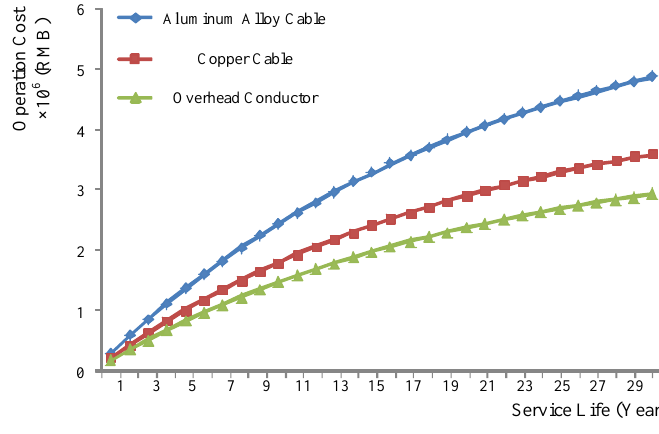
Figure 9. Operation and maintenance cost during 30 years in Case 1.